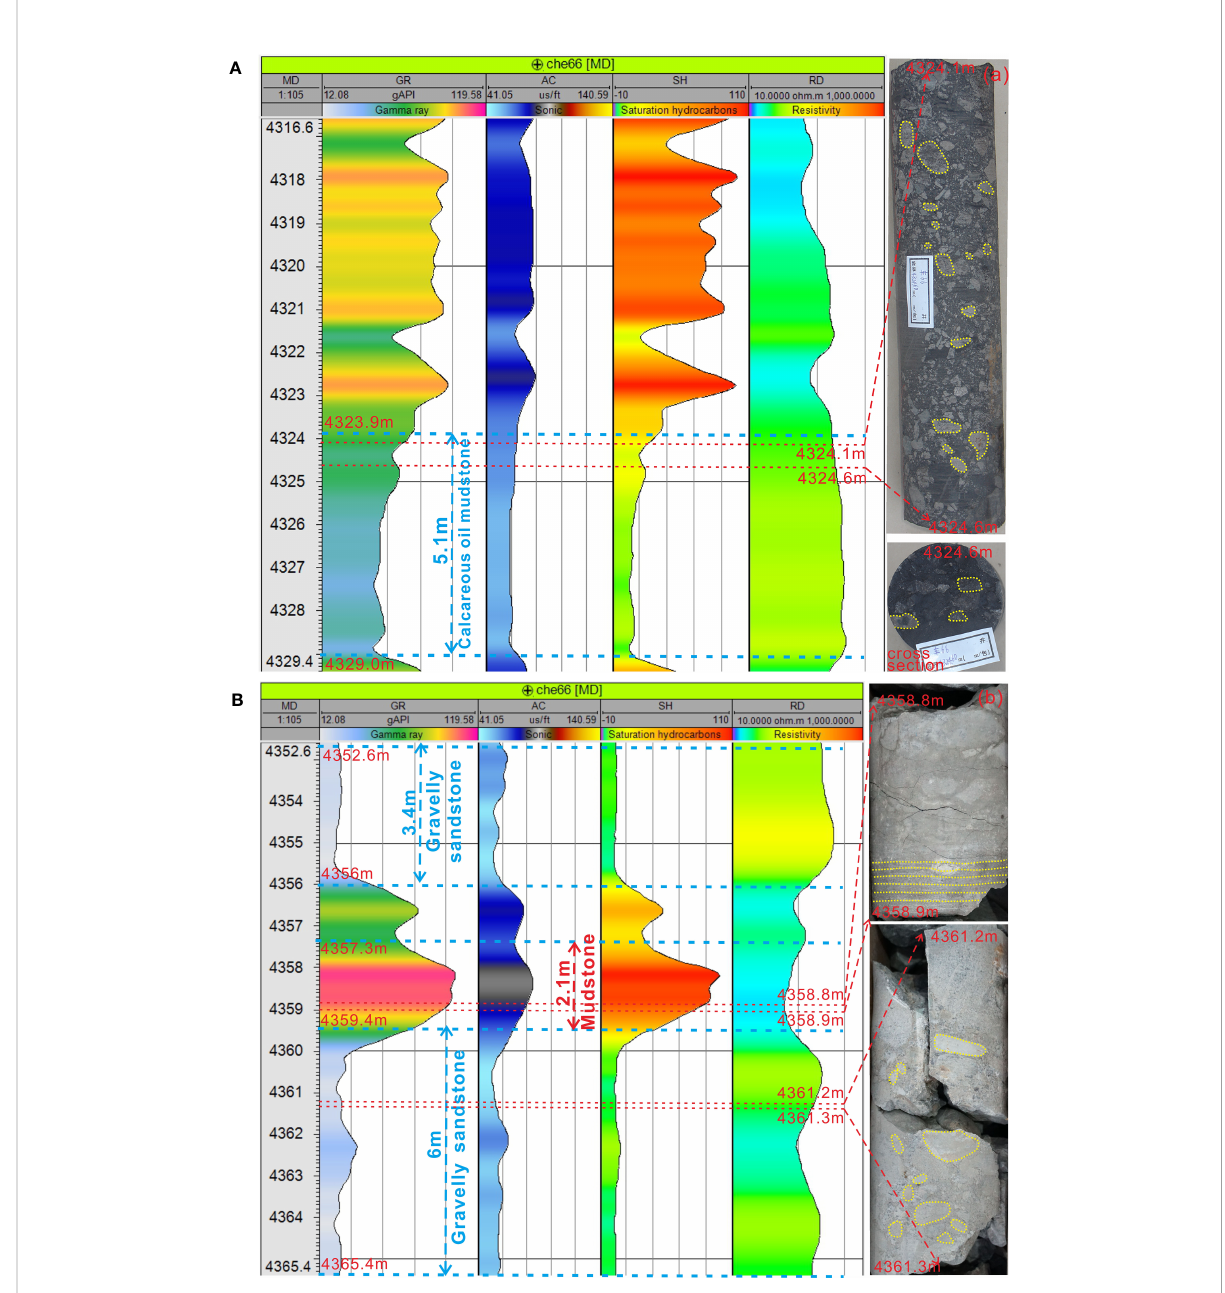
FIGURE 4 Logging curve characteristics and core characteristics of Well Che 66. (A) Calcareous oil mudstone of Well Che66 is at 4323.9-4329.0 m. The core is calcareous oil mudstone, which is dark. The yellow dotted circle on the core picture is the calcite mud crystal. The core depth is 4324.1- 4324.6 m. The core can be related to the logs by depth. (B) Gravelly sandstone of Well Che66 is 4352.6-4356.0 m and 4359.4-4365.4 m. Mudstone of Well Che66 is in 4357.3-4359.4 m. The core depth is 4358.8-4358.9 m (mudstone) and 4361.2-4361.3 m (gravelly sandstone). The core can be related to the logs by depth. The yellow dotted line on the core picture is the horizontal texture during mudstone deposition. The yellow dotted circle on the core picture is mud gravel. We counted the data from 22 well logs and found that the lithologic and electrical characteristics of the lower Sha 3 submember are consistent. Calcareous oil mudstone has medium gamma rays, low acoustic wave time difference, low SH and high RD. Gravelly sandstone is characterized by low GR, low AC, low SH and high RD. Mudstone is characterized by high natural gamma rays, high acoustic transit time, high SH and medium low RD. The crossplot can clarify the differentiation of the above four electrical characteristics for lithology. Taking the well-logging data of P2S3X from Well Che 66 as an example, we completed the production of six kinds of crossplots: GR and AC, GR and SH, GR and RD, AC and SH, AC and RD, and SH and RD. Lithology is used as the intersection background. The crossplot indicates that for the Taoerhe Sag, GR can only be selected if gray oil mudstone and gravelly sandstone are to be distinguished. If we want to distinguish calcareous oil mudstone and mudstone, we can choose GR, AC, or SH. If we want to distinguish mudstone from gravelly sandstone, we can choose GR, AC, or SH. In conclusion, GR can better distinguish